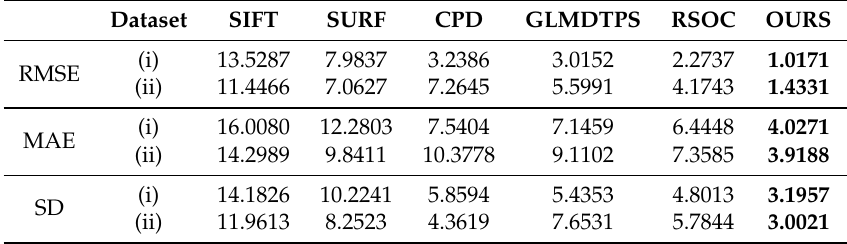
Table 4. Experimental results on series (II). Quantitative comparisons on image registration measured using the mean RMSE, MAE and SD are carried out. Bold fonts indicate the best results. All units are in